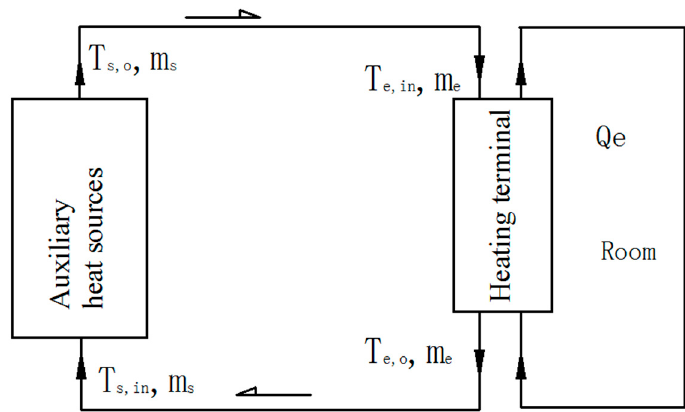
Figure 13. Operation model of the heat supply to the room by the auxiliary heat sources.